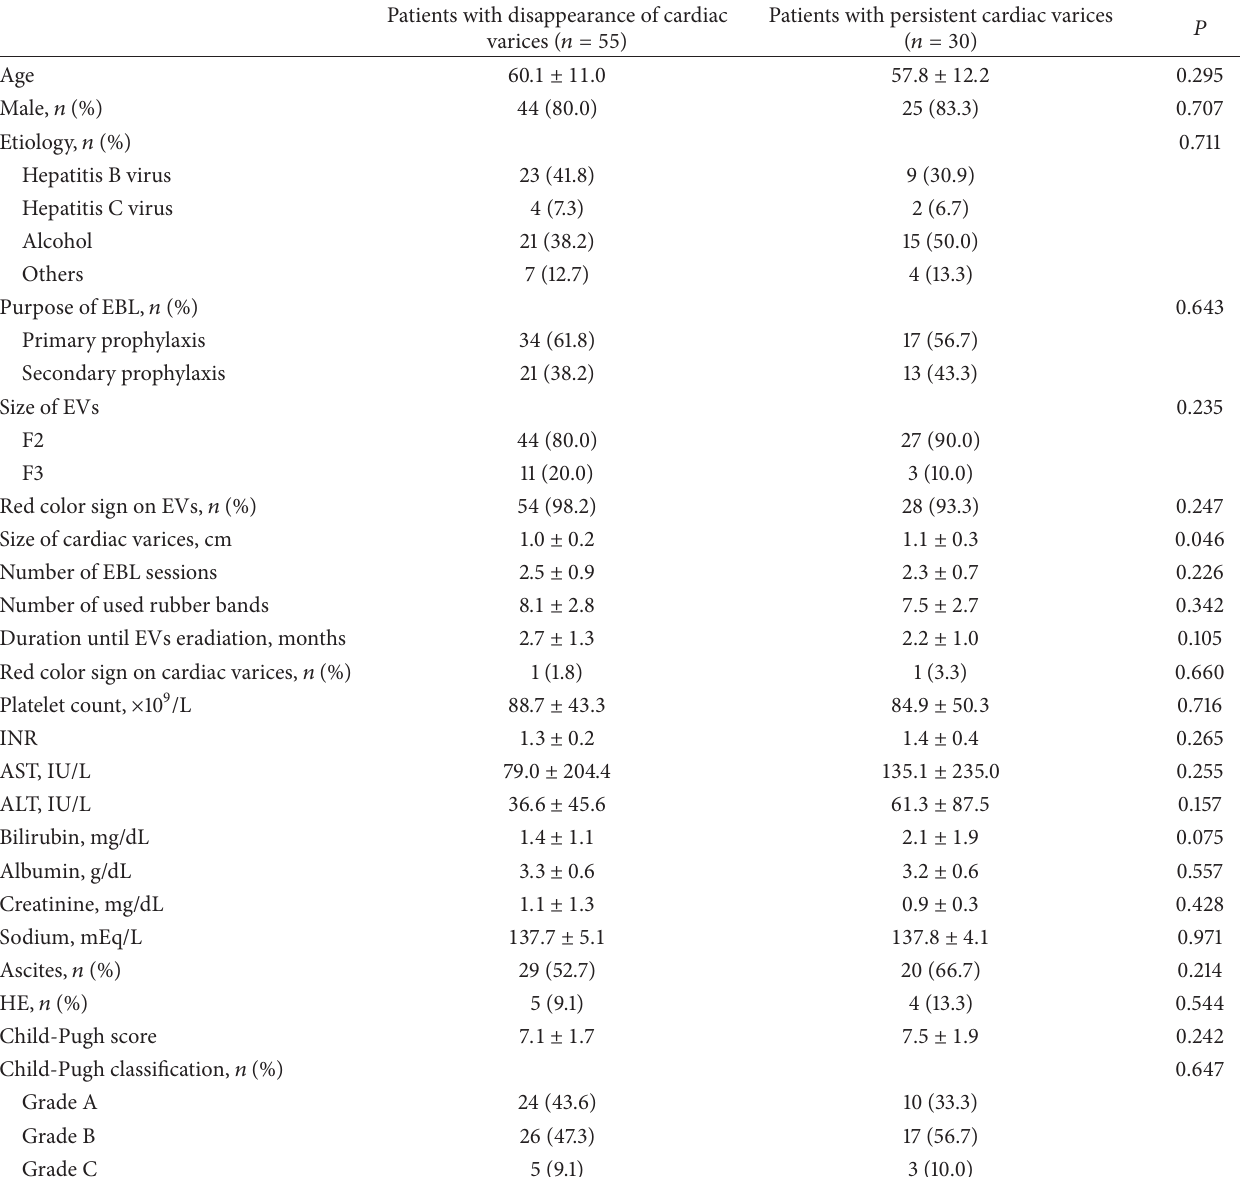
Table 2: Baseline characteristics of patients with GOV1s—arranged according to the changes in cardiac varices after eradication of esophageal varices by endoscopic band